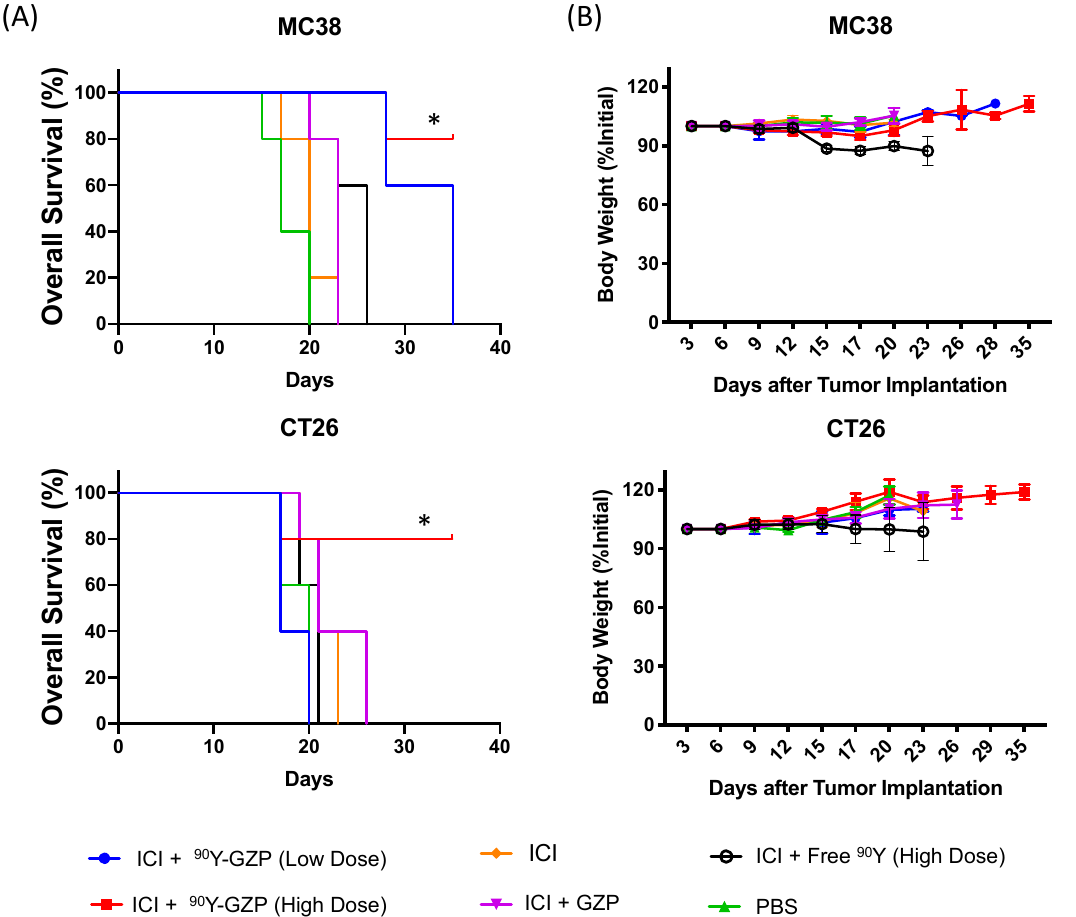
Figure 3. ( A ) Overall survival plots of MC38 and CT26 tumor-bearing mice. Significantly increased overall survival was achieved for ICI followed by 22.2 MBq of 90 Y-GZP (high dose) in both tumor models as well as ICI followed by 2.2 MBq of 90 Y-GZP (low dose) in animals bearing MC38 tumors. ( B ) Body weight measurements carried out throughout the study reveal no signs of overall toxicity in any of the treatment groups. * Statistically significant when compared to all other groups at the end of the study ( p < 0.05).